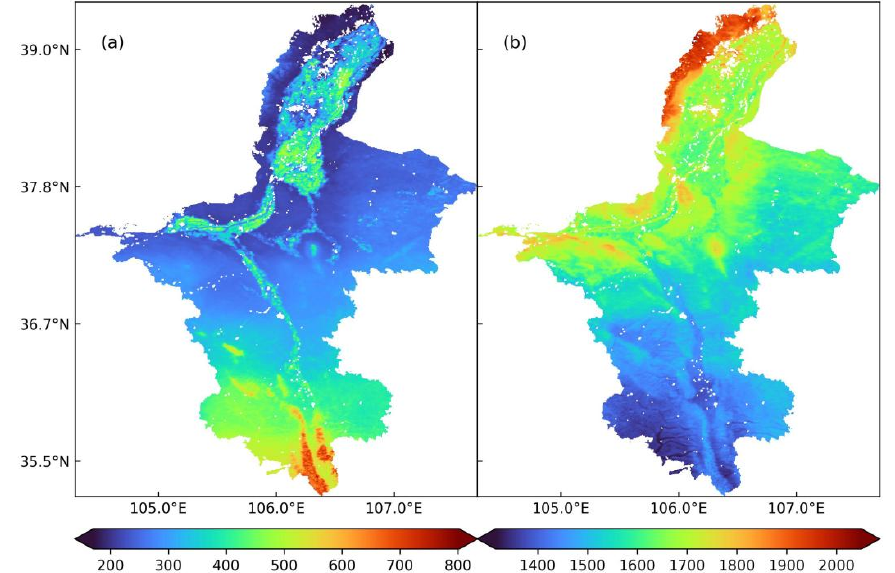
Figure 2. Assessment of annual average AET and PET in Ningxia from 2001 to 2020. ( a ) Annual average AET. ( b ) Annual average PET.